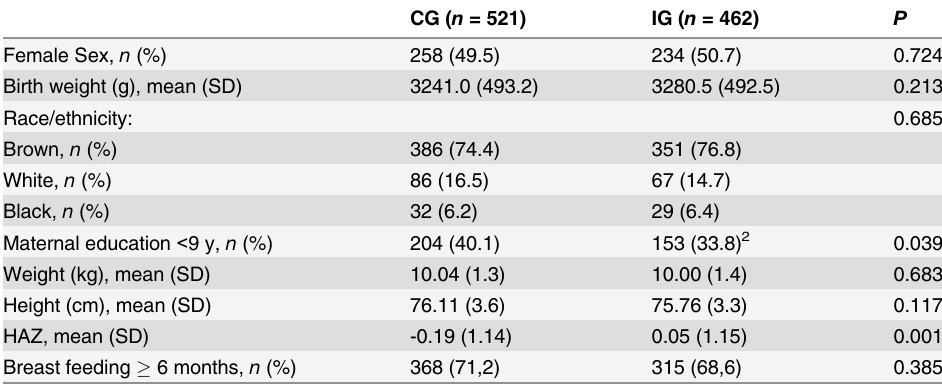
Table 2. Characteristics of the participants by ENFAC study groups a .